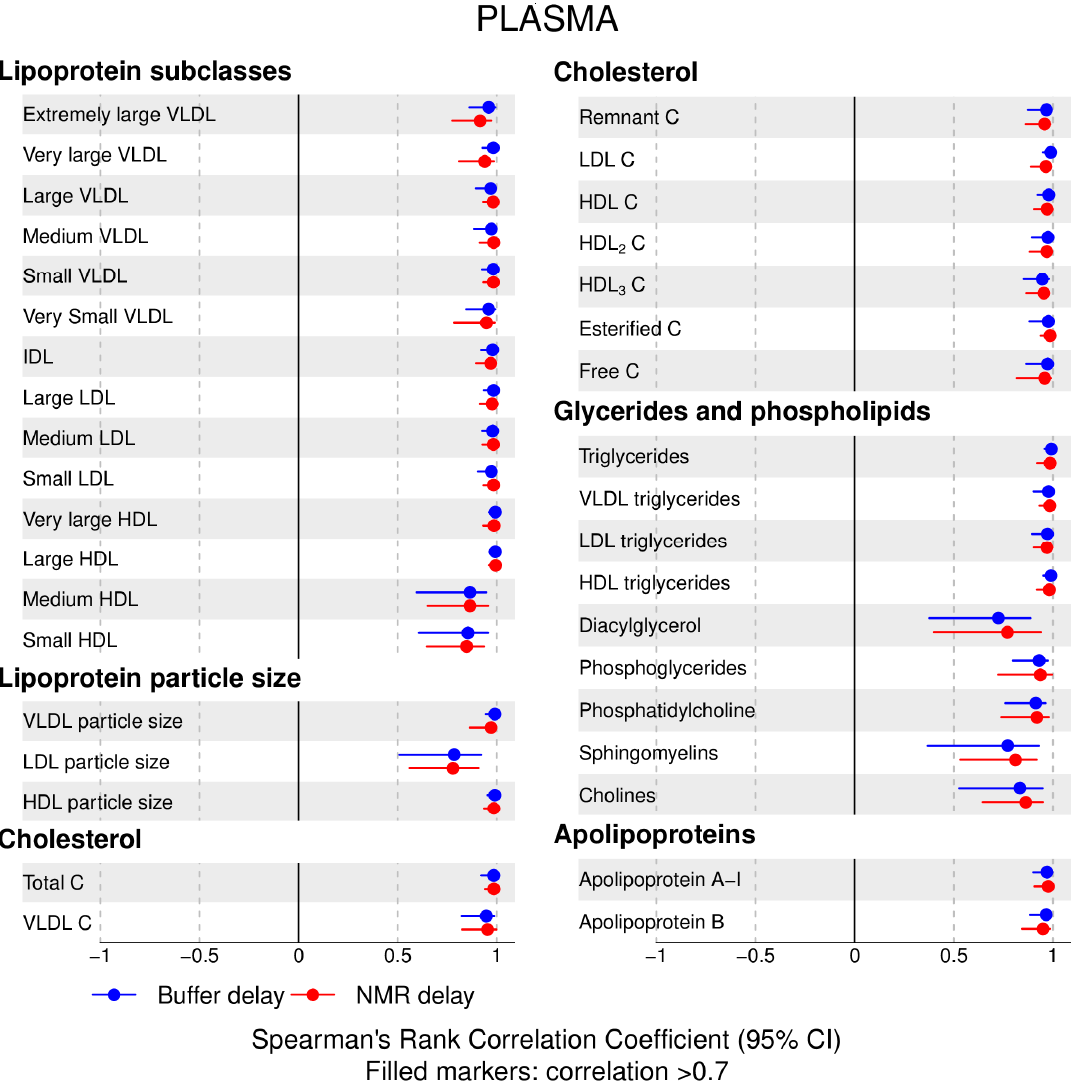
Figure 7 . EDTA-plasma, post-storage handling effects: Spearman’s rank correlation coefficients Figure 7. EDTA-plasma, post-storage handling effects: Spearman’s rank correlation